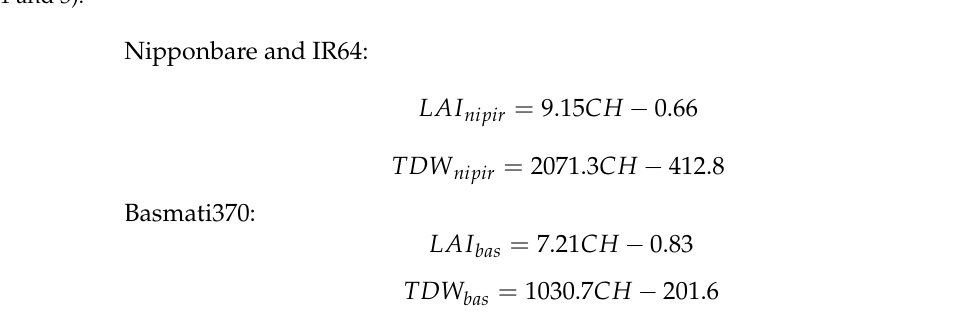
Figure 9. Relationship of ( a ) Leaf area index (LAI) and ( b ) aboveground biomass dry weight (TDW) with measured plant height in 2018 (Rep. 1 and